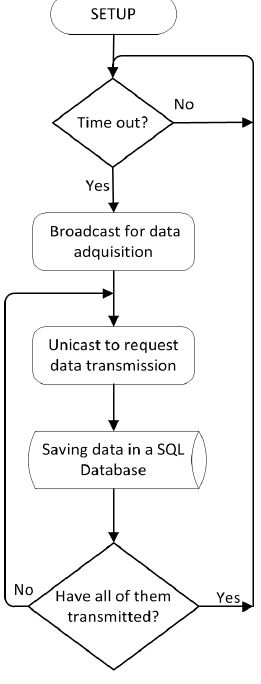
Figure 5. SCADA user interface.